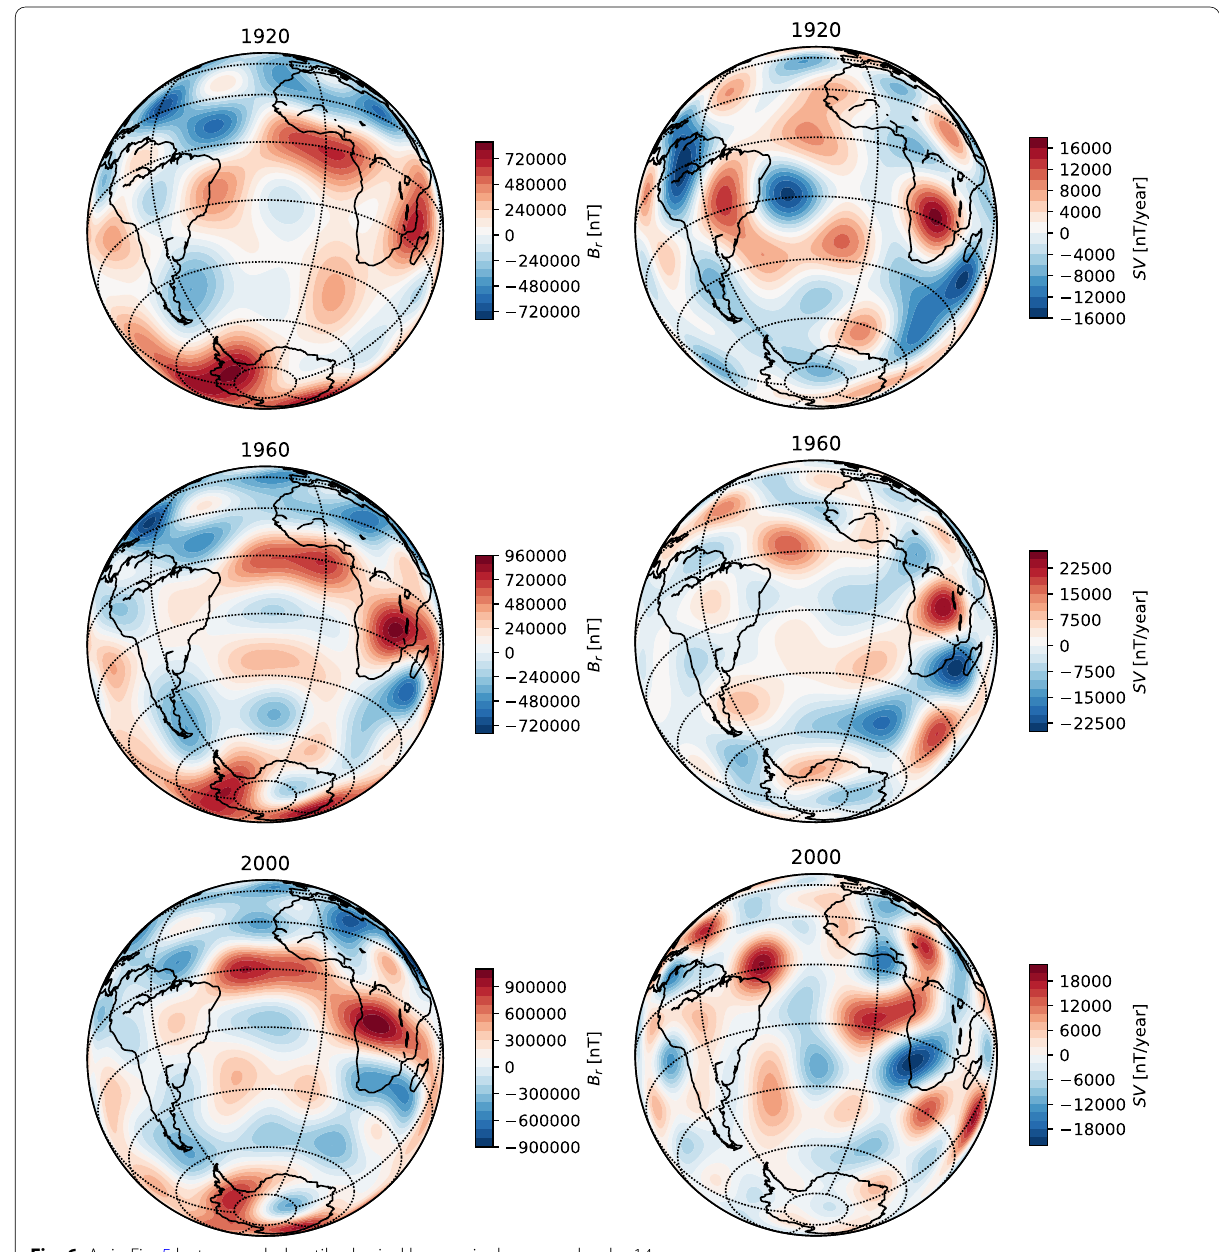
Fig. 6 As in Fig. 5 but expanded until spherical harmonic degree and order